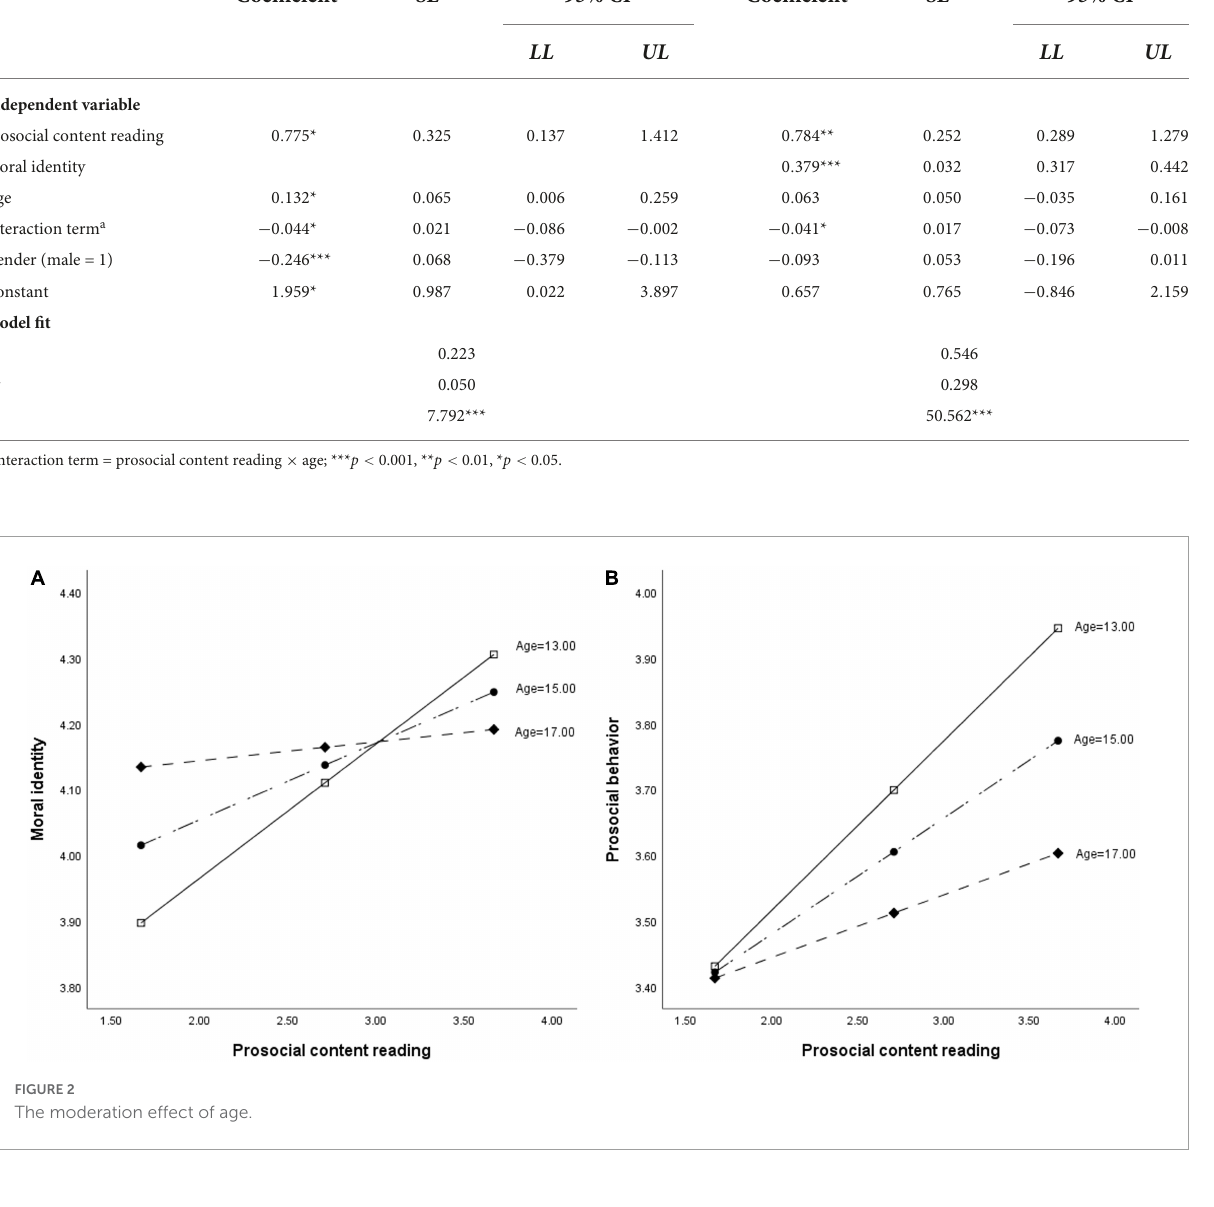
TABLE 4 The conditional direct and indirect